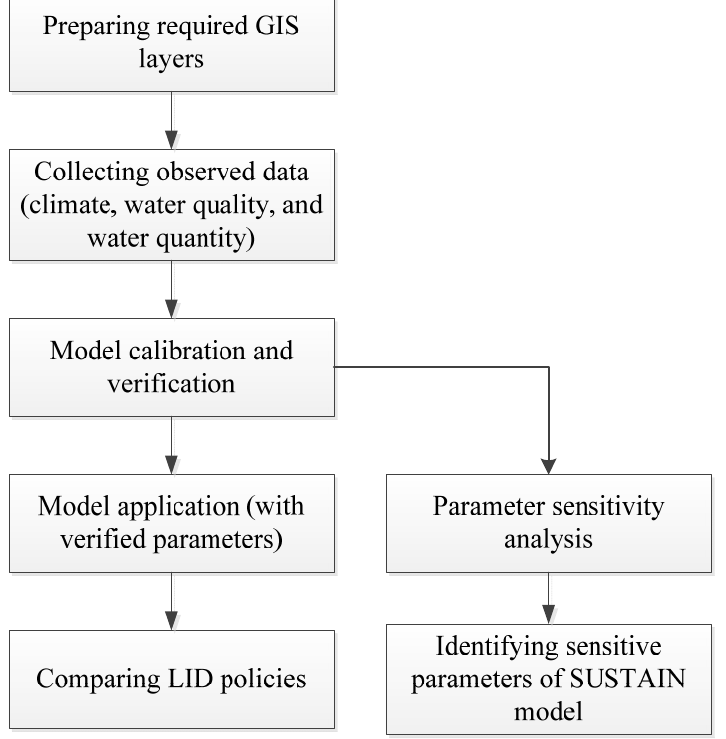
Figure 2. Model simulation process in this